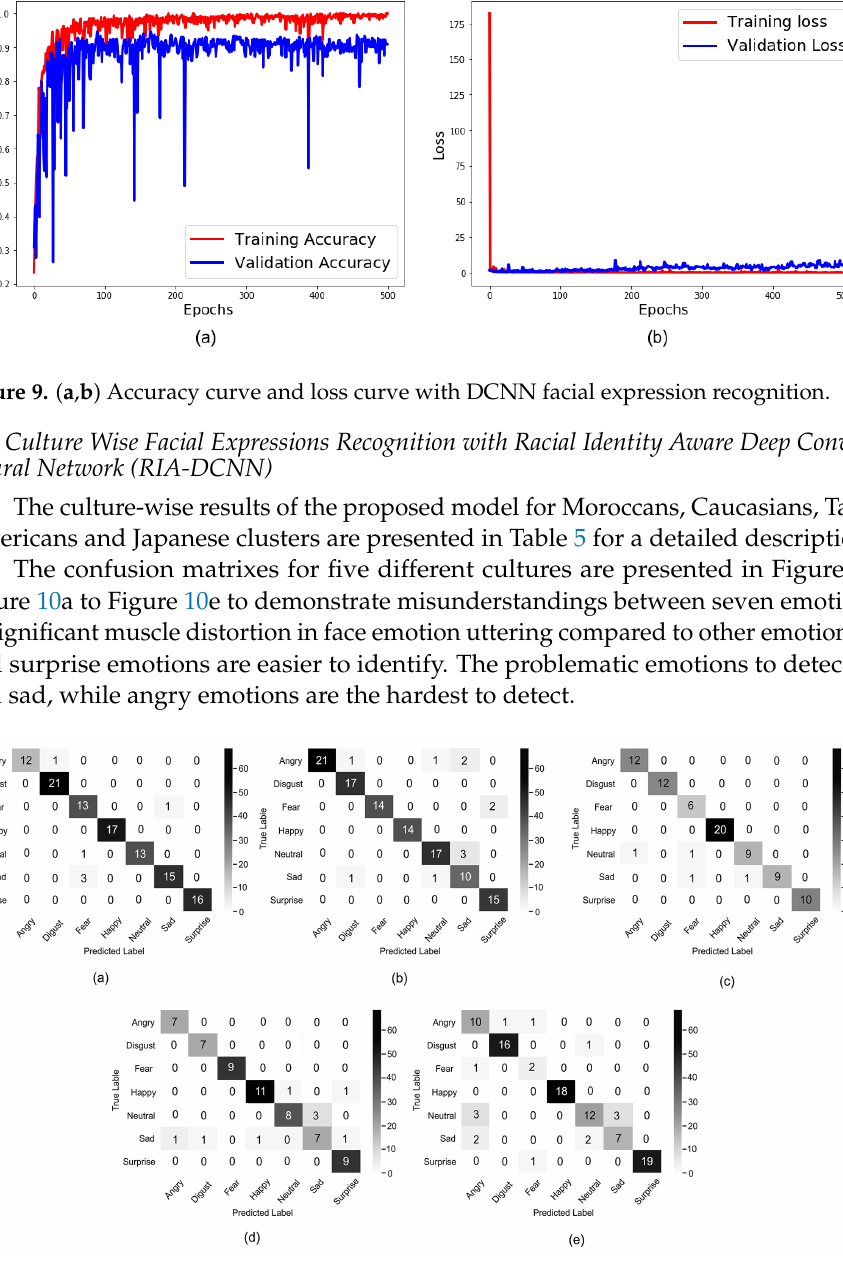
Figure 10. Confusion Matrix of multicultural groups namely ( a ) Moroccans; ( b ) Caucasians; ( c ) Tai- wanese; ( d ) Americans; and ( e ) Japanese for seven emotions with Deep Convolutional Neural Network Facial Expression